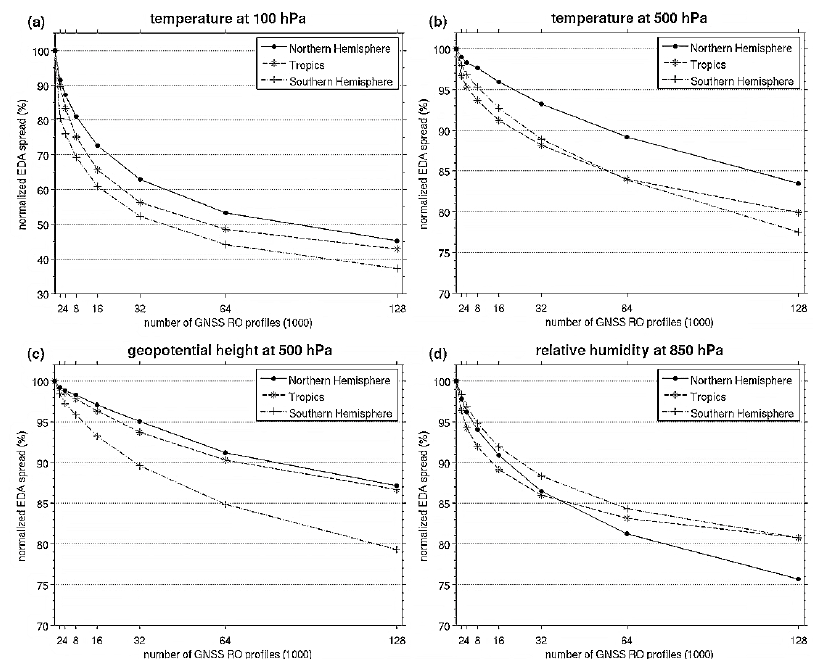
Figure 7. Normalized ensemble of data assimilation (EDA) spread (%) as a function of the assimilated number of simulated RO profiles [46]. The EDA spread is an error statistic of the ECMWF NWP theoretical forecast and analysis. ( a ) Temperature at 100 hPa; ( b ) temperature at 500 hPa; ( c ) geopotential height at 500 Pa; ( d ) relative humidity at 850 hPa. The more the RO observations, the better the NWP, and there is no saturation even with 128,000 soundings per day.